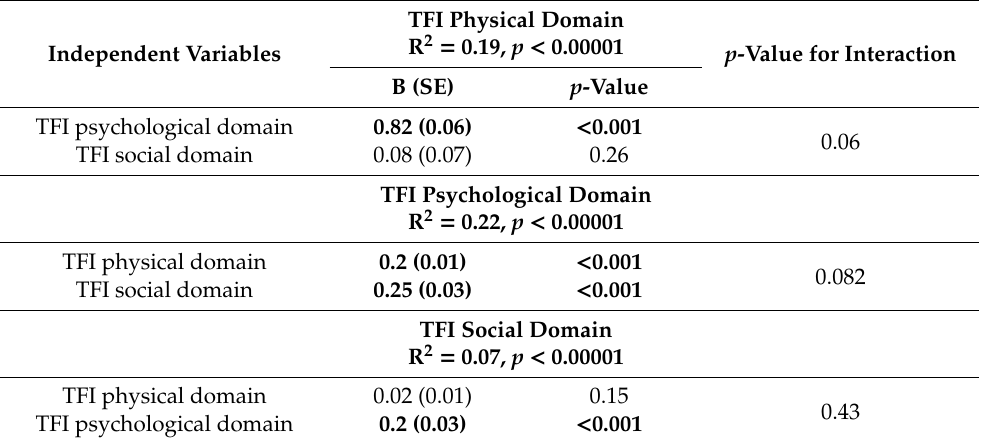
Table 4. The association between di ff erent frailty domains according to TFI and their interactions in the multiple regression